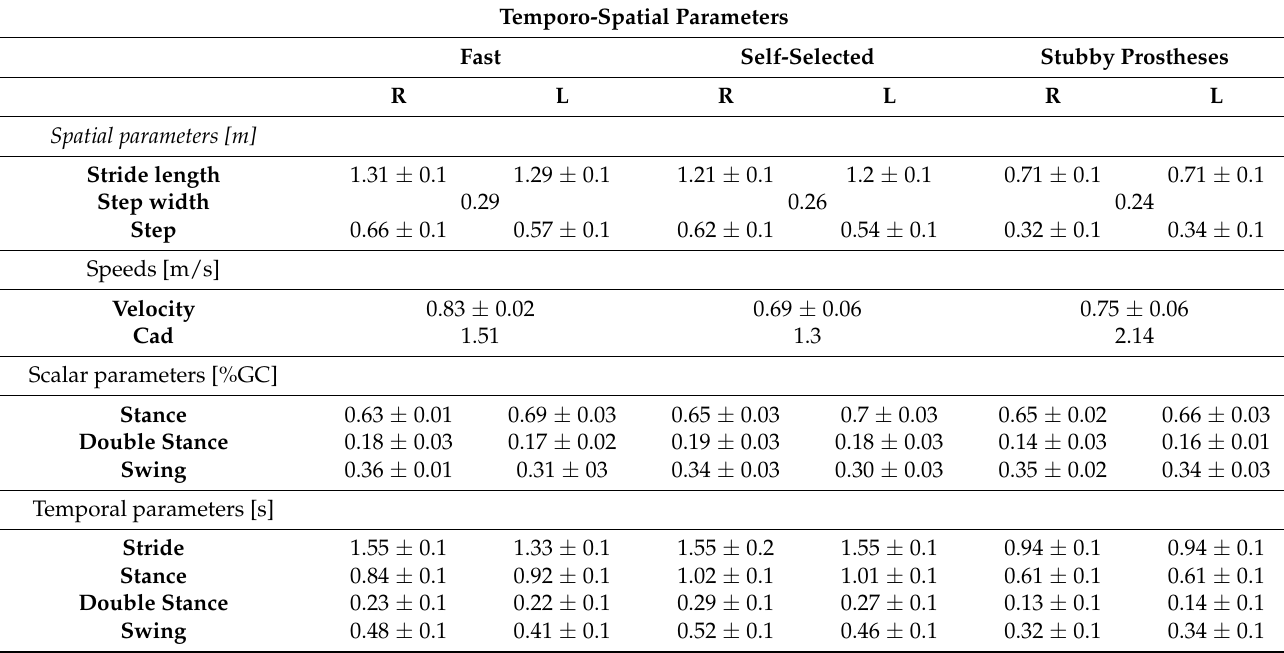
Table 1. Mean and ± standard deviation of temporo-spatial parameters for prosthetic gait (fast gait, self-selected gait speed and gait with stubby prostheses—stubbies).